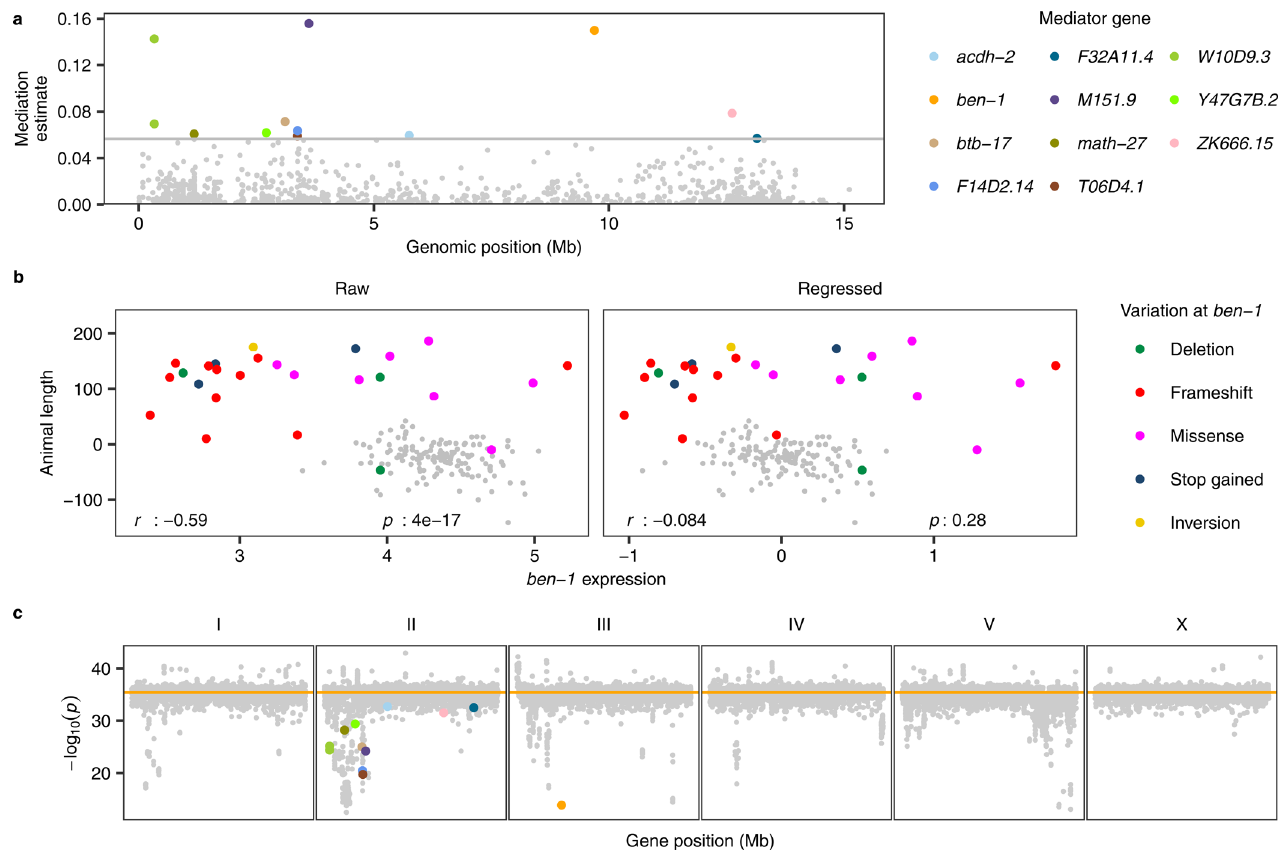
Fig. 4 Mediation effects of ben-1 expression on C. elegans resistance to albendazole. a Mediation estimates ( y -axis) calculated as the indirect effect that differences in expression of each gene play in the overall phenotype are plotted against the genomic position of the eQTL ( x -axis) on chromosome II. The horizontal gray line represents the 99th percentile of the distribution of mediation estimates. Signi fi cant mediators are colored other than gray by their genes as shown in the legend. b The correlation of animal length ( y -axis) to raw ben-1 expression and to ben-1 expression regressed by variation at ben-1 on y -axis. The correlation coef fi cient r and the p values using the two-sided Pearson ’ s correlation tests were indicated at the bottom. Strains are colored by the type of their genetic variants in ben-1 . Strains without identi fi ed variants are colored gray. c Signi fi cance at the pseudo variant marker of 25,837 GWA mappings. Each point represents a GWA mapping that is plotted with its − log 10 ( p ) value ( y -axis) at the pseudo variant marker (III: 3,539,640) against the genomic locations (x-axis) of the transcript of which the expression was used in regression for animal length. Points for traits regressed by expression of transcripts identi fi ed as signi fi cant mediators are colored as in a . The orange horizontal line represents the signi fi cance of the pseudo variant marker using the raw animal length of 167 strains (Supplementary Fig. 6). GWA mapping results of 12 traits regressed by expression of mitochondrial genes were excluded but all with signi fi cance close to the horizontal line. We used the GWAS() function in the R package rrBLUP 87 to perform the genome-wide mapping with the EMMA algorithm 32 (see “ Methods ” exogenous zinc using linkage mapping experiments 9,13 . To vali- date whether our expression and eQTL data can be used to identify candidate genes, we fi rst performed mediation analysis on one published GWA study of variation in responses to the commonly used anthelmintic albendazole (ABZ) 42 .